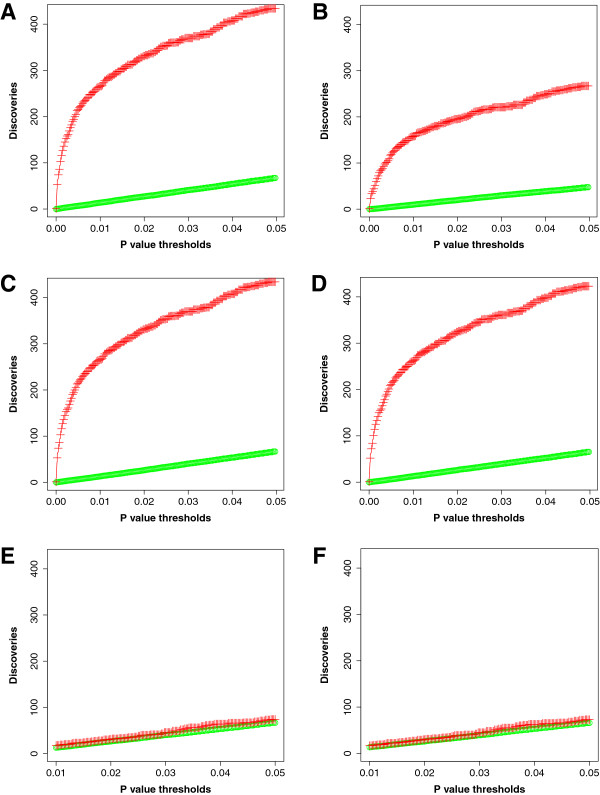
Discoveries with Global FDR correction for Mann–Whitney U test. Mann–Whitney U tests with FDR correction were performed on unclustered (A, C, E) and clustered (B, D, F) datasets. In each panel, the number of discoveries with p < 0.05 is plotted in red crosses, while the average number of discoveries of the data permuted 100 times is plotted with open green circles. A) original dataset of 1350 peaks; B) original dataset after technical clustering at threshold 0.5; C) simulated dataset of each peak randomized within groups; D) simulated dataset from C after technical clustering at threshold 0.5; E) simulated dataset of each peak fully randomized; F) simulated dataset from E after technical clustering at threshold 0.5.